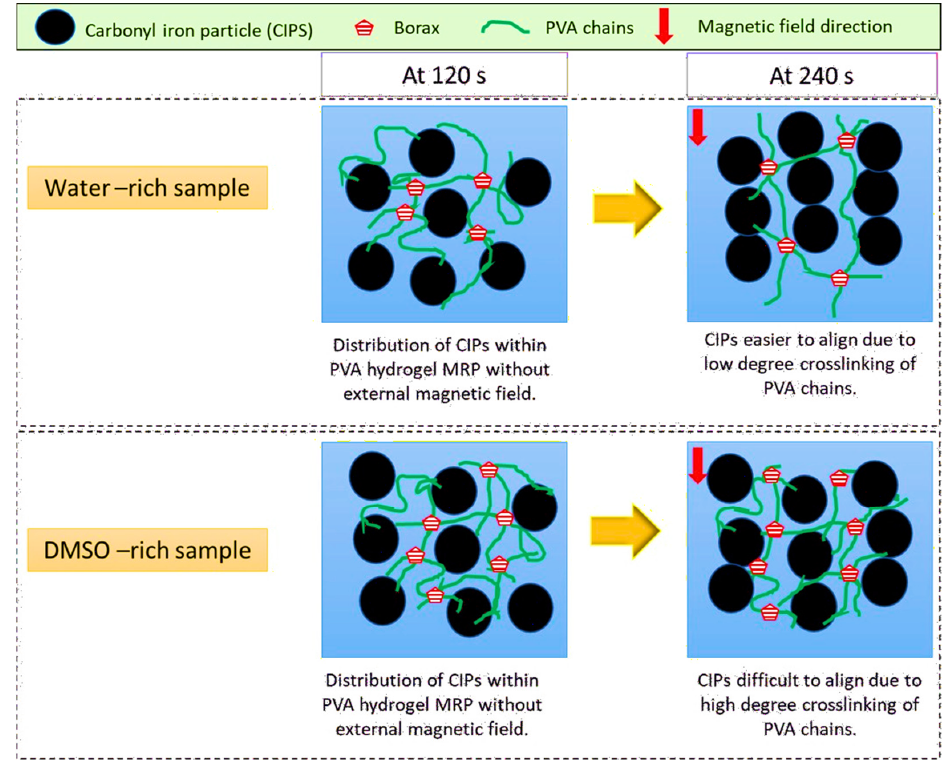
Figure 6. Schematic illustration of the mechanism of CIP movement upon the application of external magnetic field in water-rich and DMSO-rich PVA-based MRP.